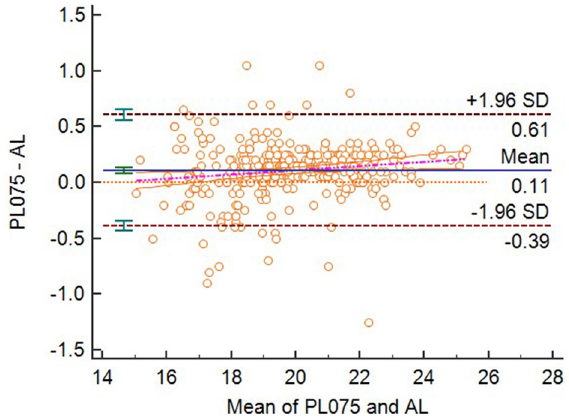
Figure 5. Bland–Altman plot for the agreement of 3D-PL and AL measurements at voxel size of 0.075.